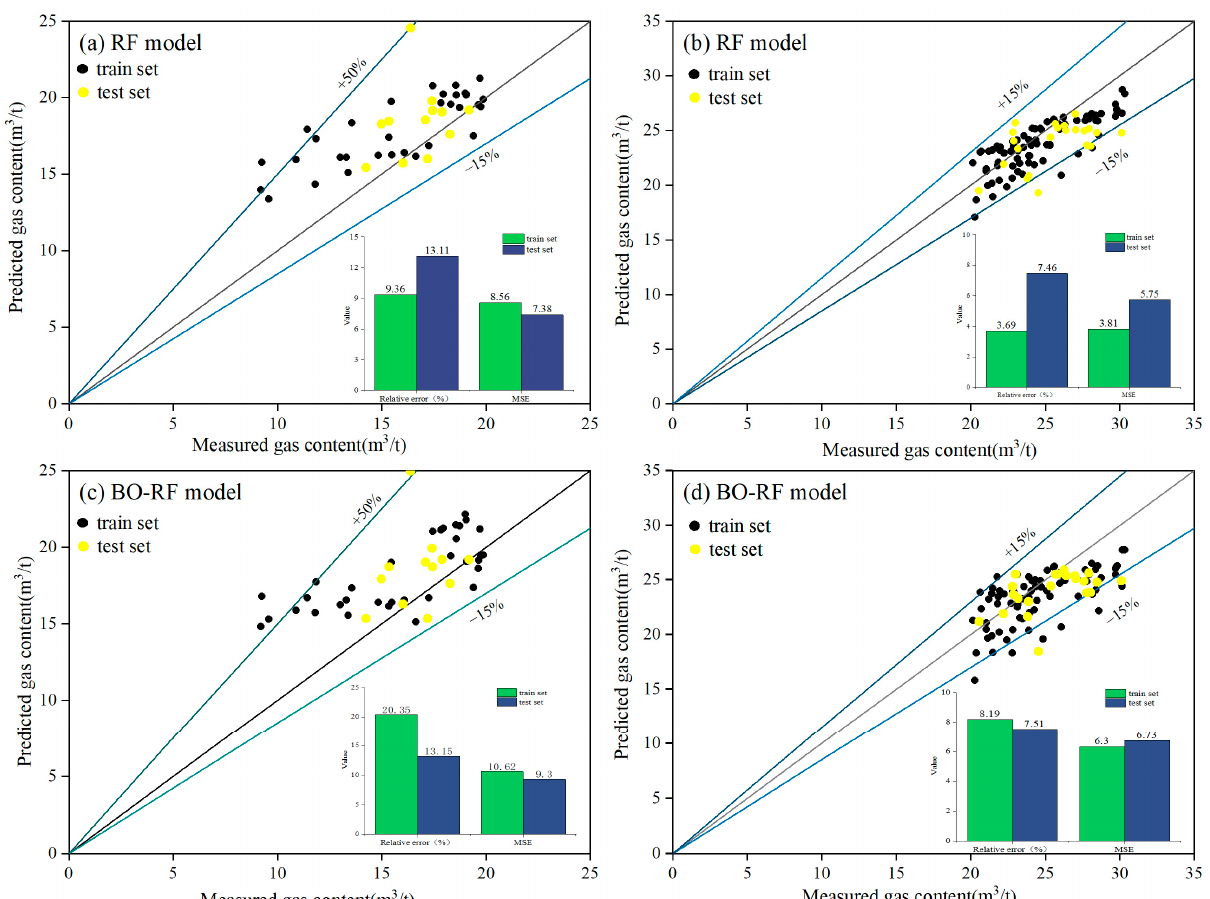
Figure 9. The different performance for low gas content and high gas content ( a gas content below 20 m 3 /t on RF model; b gas content above 20 m 3 /t on RF model; c gas content below 20 m 3 /t on BO-RF model; d gas content above 20 m 3 /t on BO-RF model).